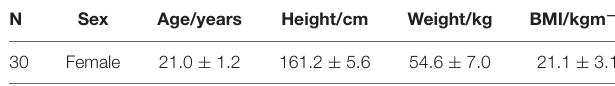
TABLE 1 | Participants’ characteristics ( ¯ x ± s ).